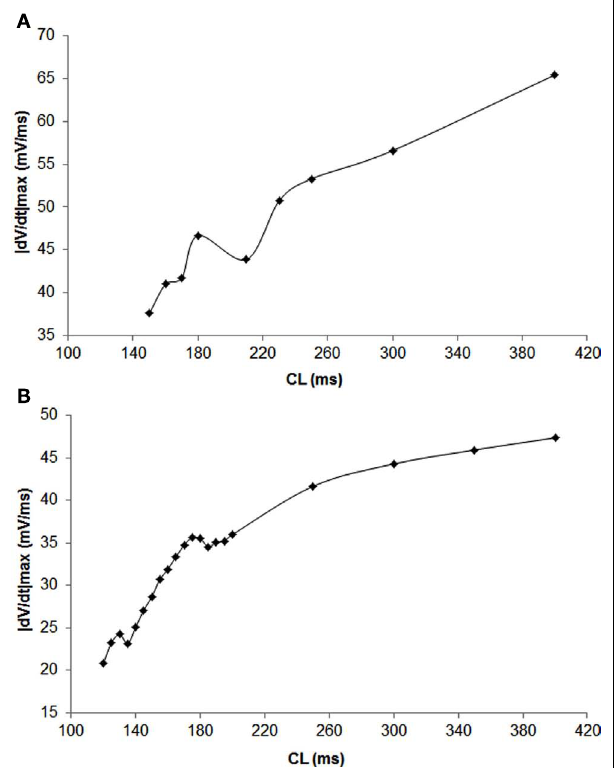
FIGURE 1 | Dependence of |d v /d t | max on CL during a trial in swine (A) and canine (B) obtained using stepwise decreasing CL pacing.